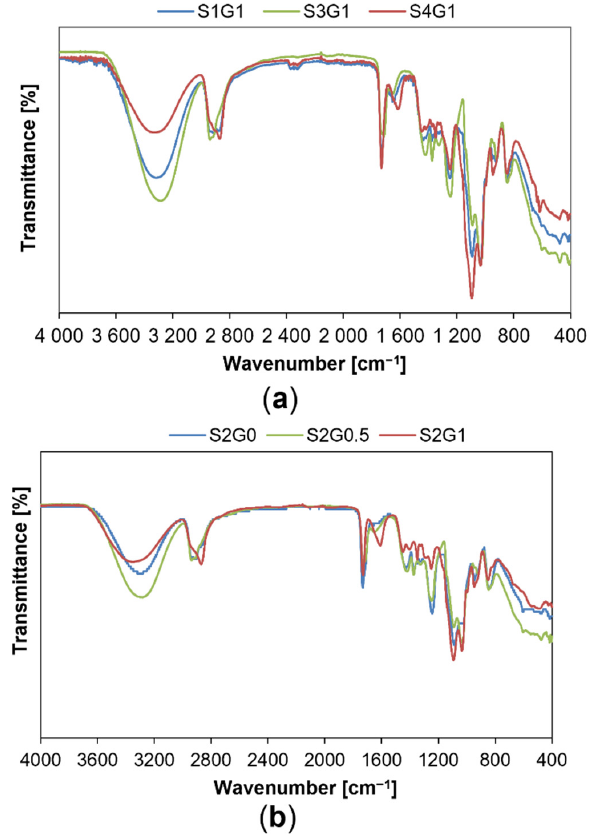
Figure 3. FTIR spectra of hydrogel samples ( a ) with a constant glycerin content (3.4%); ( b ) with varying glycerin content.